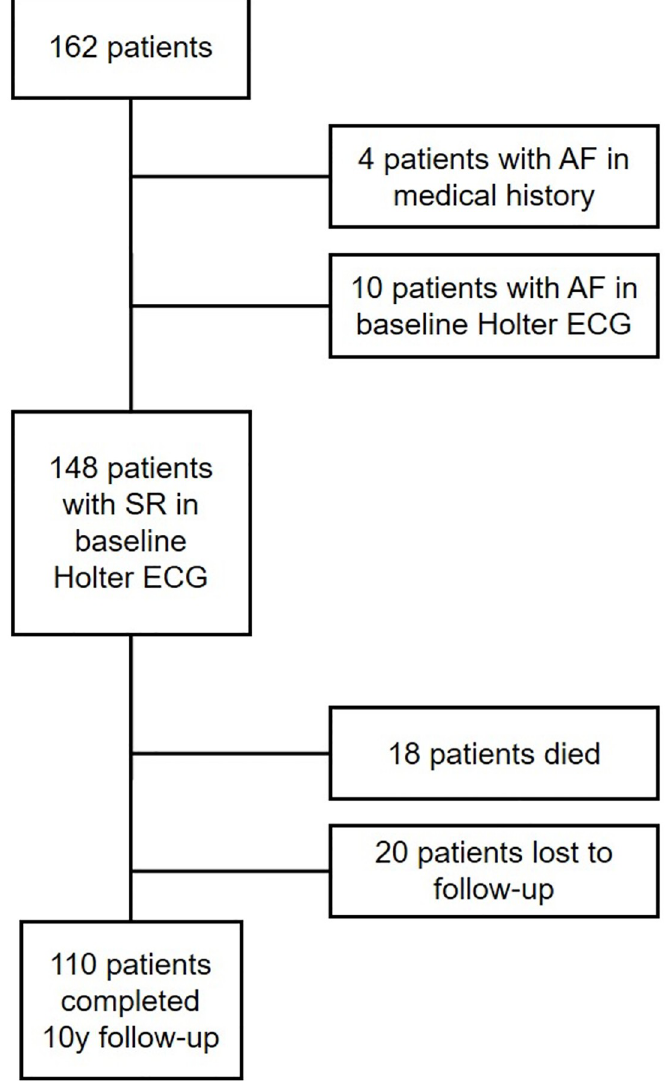
Fig 1. Study flow chart. AF = Atrial fibrillation; SR = Sinus rhythm; Of 162 patients described in Seegers et al. [14], 4 patients had AF in medical history and 10 had AF in baseline Holter ECG. Of 148 patients with SR in Holter ECG, 110 patients completed 10y-follow-up, 18 patients died, and 20 patients were lost to follow-up for other reasons. Left atrial enlargement has been shown to be predictive for AF in patients with cardiovascu- lar risk factors, population based cohorts and patients post stroke [4, 5, 23]. Most studies inves- tigated left atrial diameter (LAD), not left atrial volume, although LAVI has been recognized as a better predictor of AF than LAD or indexed LAD [6]. However, most studies performed mul- tivariable analyses with echocardiographic measurements and clinical covariates but did not analyze ESVEA and PTFV . We observed an association between incident AF and LAVI in 1 univariable analysis, but this association disappeared after including ESVEA and NT-proBNP in a multivariable model. LAVI and NT-proBNP are often correlated and bare similar diagnos- tic information [24]. Our results imply that LAVI does not have incremental diagnostic value over NT-proBNP for the prediction of AF. Pagola et al. came to a similar conclusion following